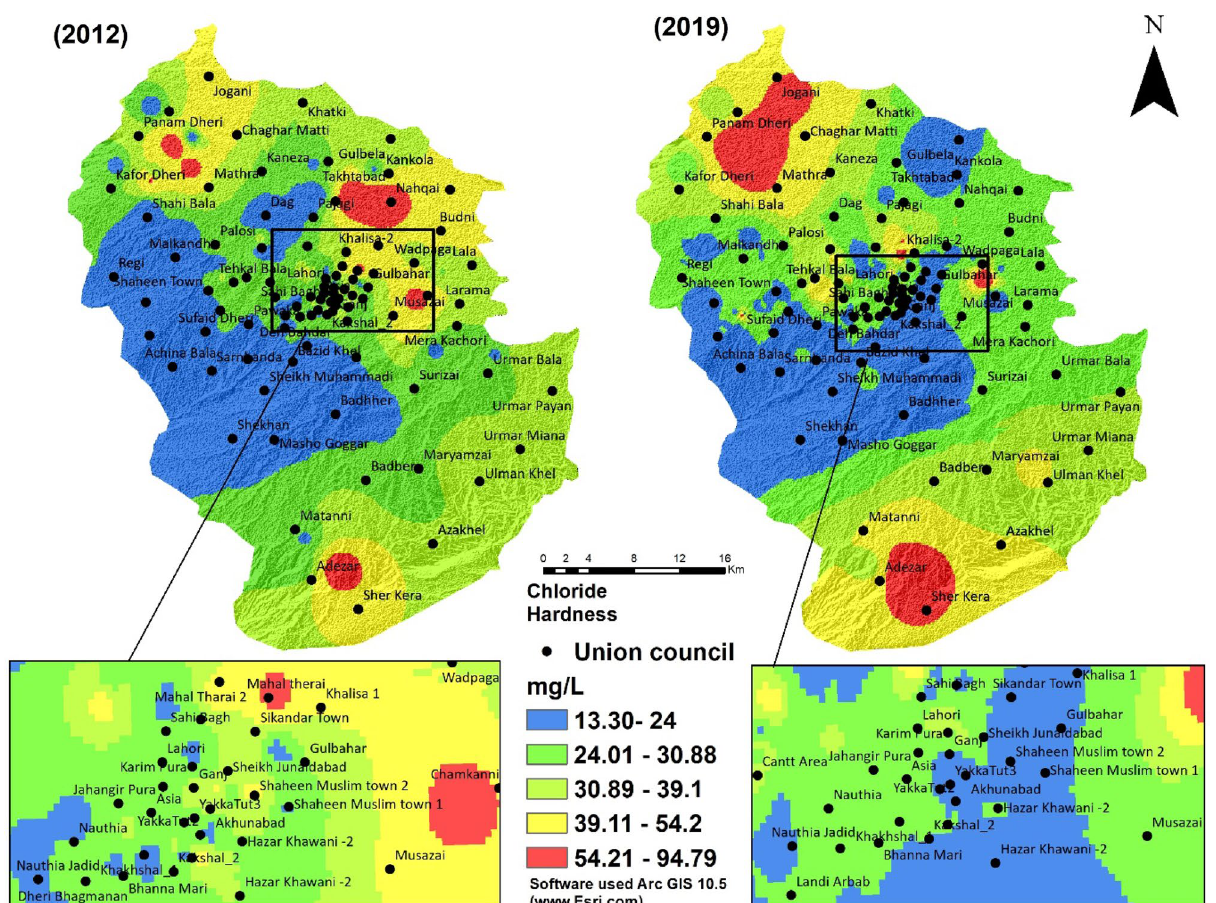
Figure 6. Chloride hardness of groundwater of 2 years (2012 and